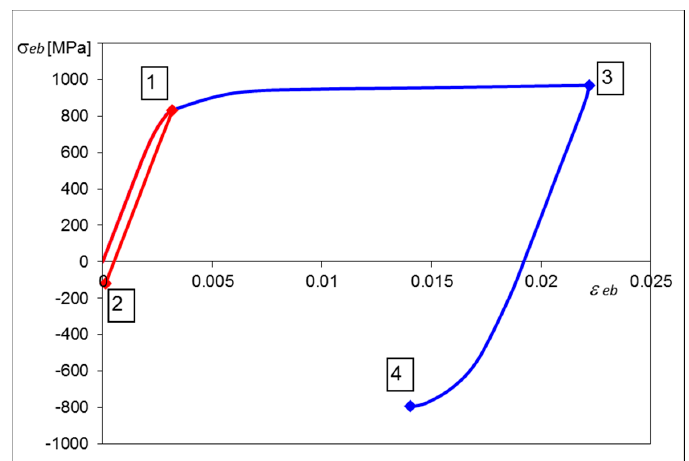
Figure 7. Equibiaxial stress–strain history at the surface center. Numerical FEM solution.